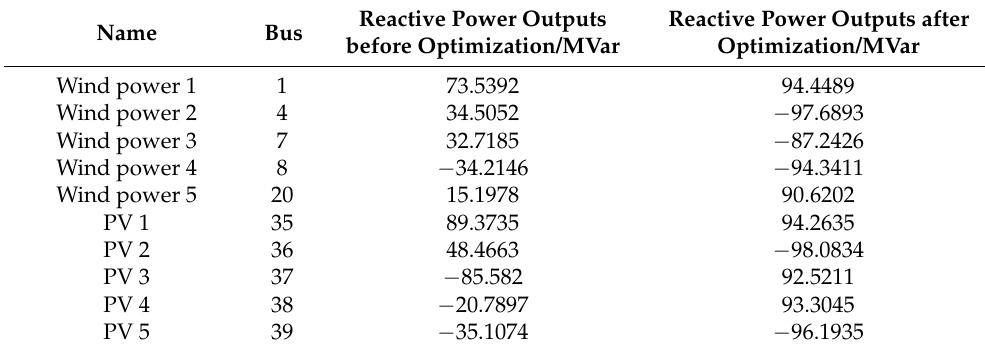
Table 5. Comparison of reactive power outputs of new energy units before and after optimization.